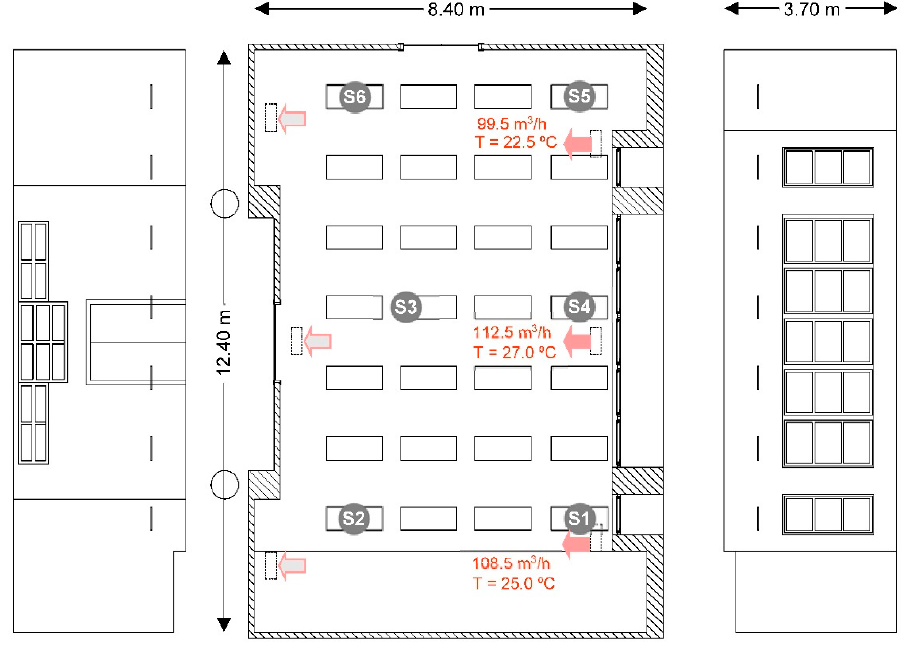
Figure 7. Typical classroom of the Architecture Technical School in Valladolid.